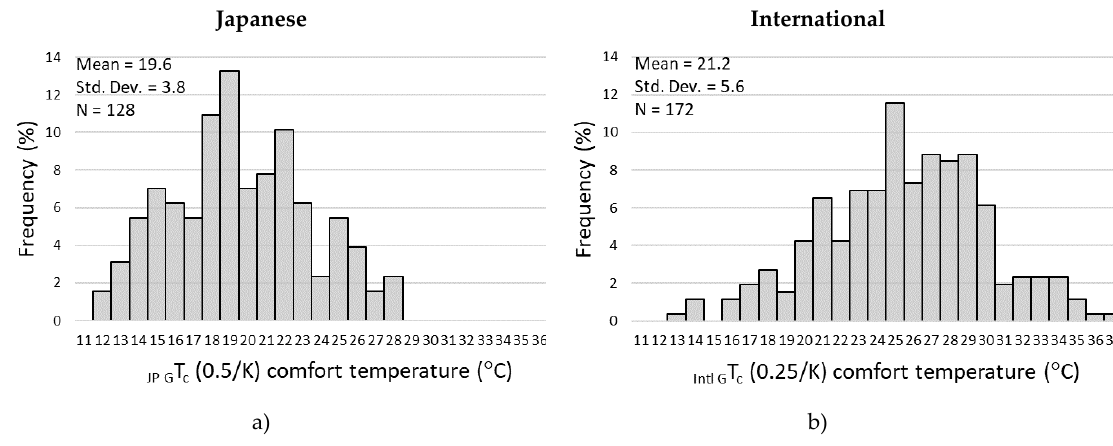
Figure 16. Griffiths comfortable temperature: ( a ) Frequency distribution of the calculated Japanese comfortable temperature; ( b ) frequency distribution of the calculated international comfortable temperature